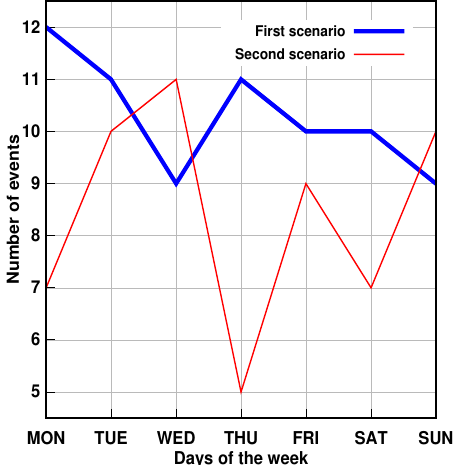
Figure 15. Cooking events.